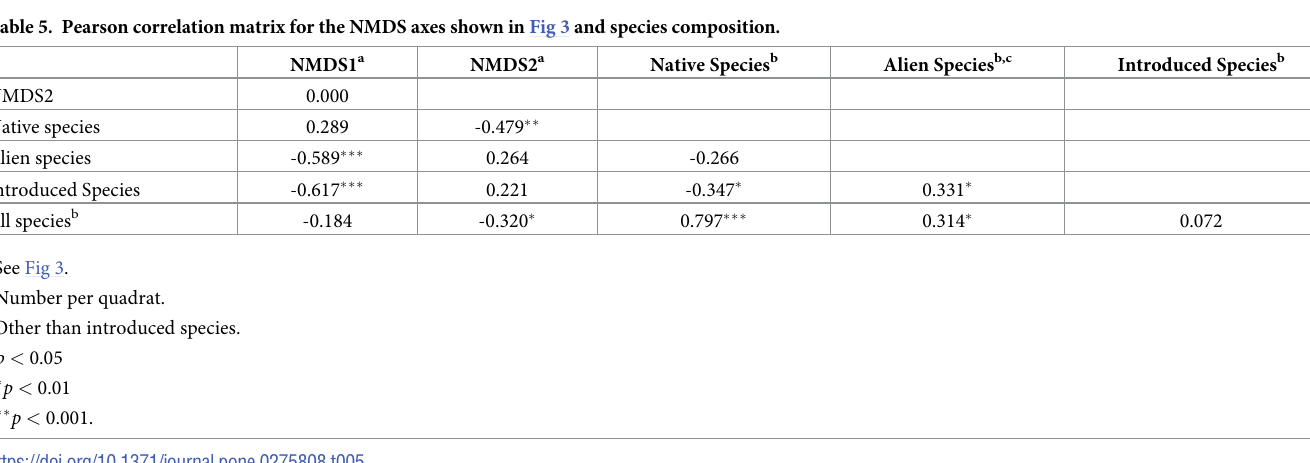
S1 Table. Plant species composition in the two pastures. Plant species recorded in the two pastures during 1972–1981 and 2019, and their mean covers (%).